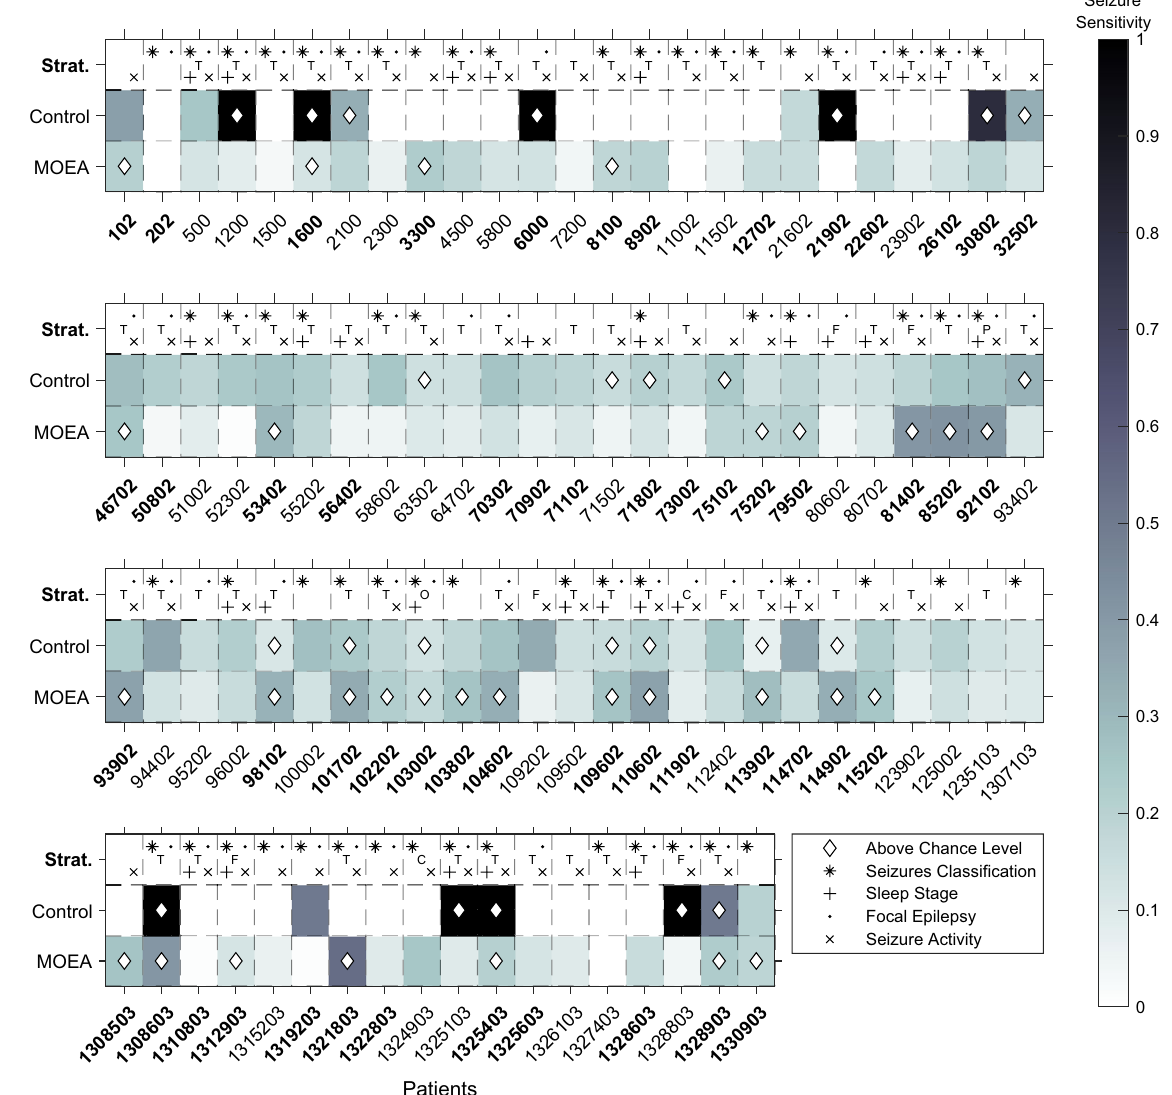
Figure 5. The test performance of all patient models, for the MOEA and the control method. Colour represents the seizure sensitivity, while the diamond shape means that the models performed above chance level. On the top line (Strat.), patient stratification is presented concerning seizure classification (*, FOA or FOIA/focal to bilateral tonic-clonic seizures), sleep stage at seizure onset (+, awake/sleep), type of epilepsy (., focal/generalised) and annotated activity pattern (x, rhythmic/non-rhythmic), and seizure focus that is lobe-specific (temporal (T), frontal (F), central (C), parietal (P), occipital